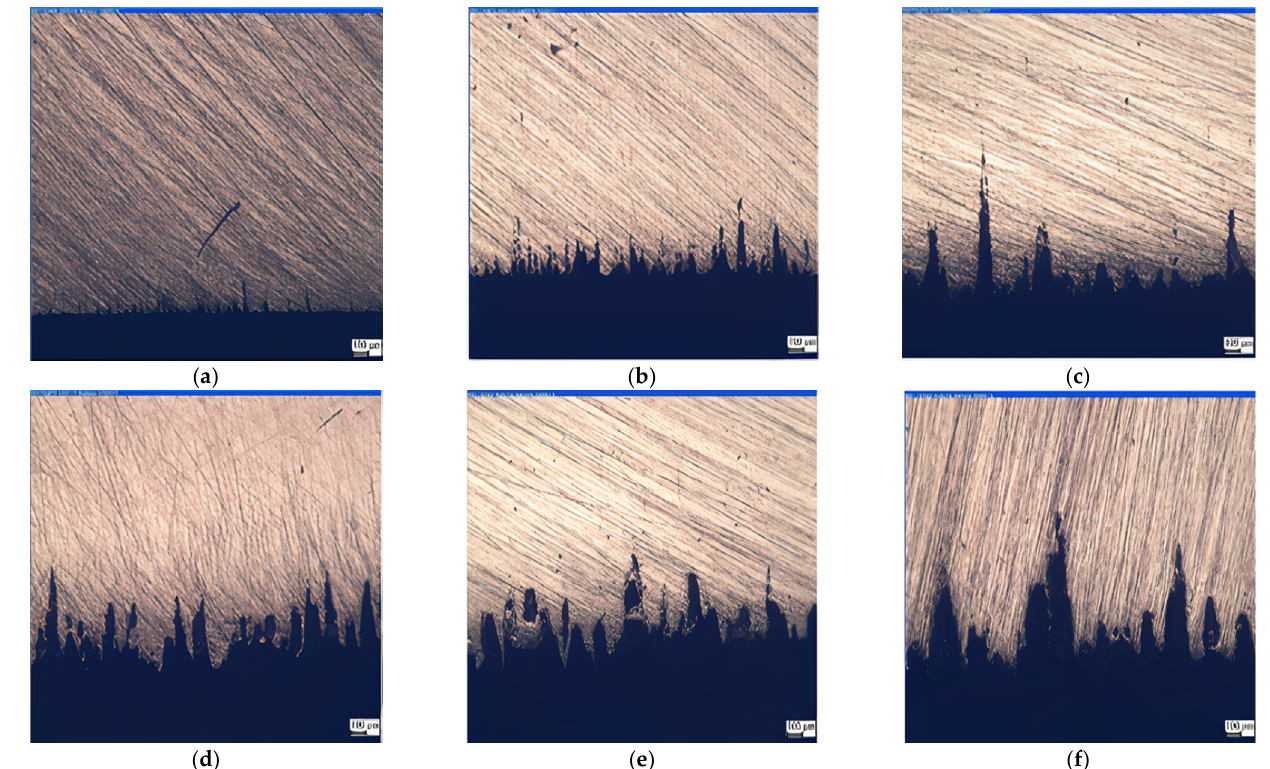
Figure 3. Observation of corrosion thickness using optical microscope. ( a ) The corrosion time is 2 h; ( b ) the corrosion time is 4 h; ( c ) the corrosion time is 6 h; ( d ) the corrosion time is 8 h; ( e ) the corrosion time is 10 h; ( f ) the corrosion time is 12 h.